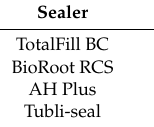
Table 2. Setting times of the endodontic sealers as stated by the manufacturers.